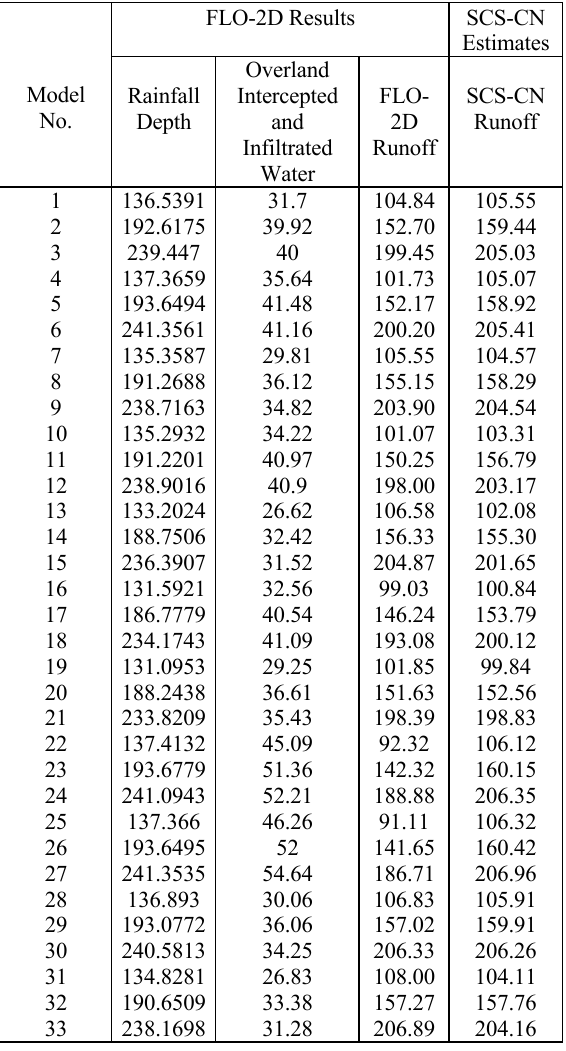
Table 3. FLO-2D Runoff Output and SCS-CN